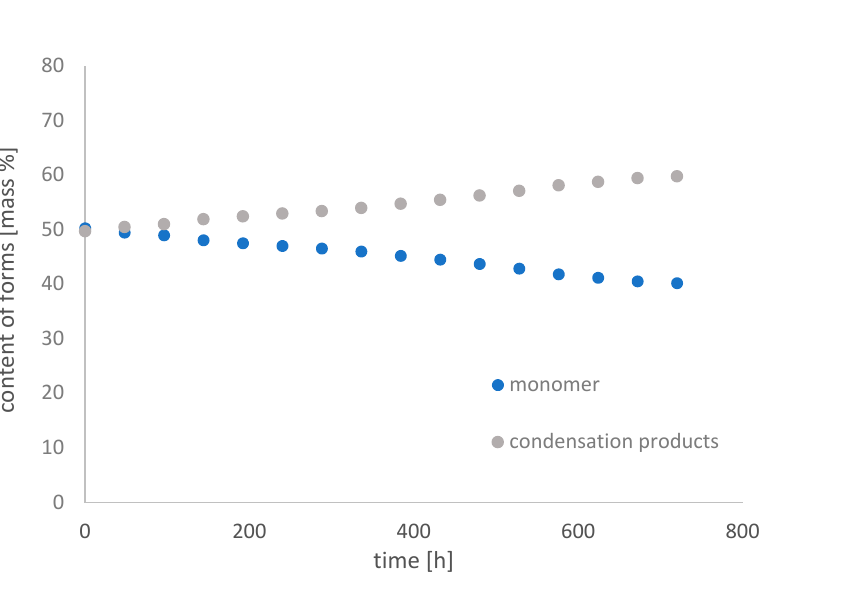
Figure 11. Change in the content of iron(III) ethylenediamine- N,N ′ -di[(2-hydroxy-5- sulfophenyl)acetic acid] forms with time in an aqueous solution at pH 3.